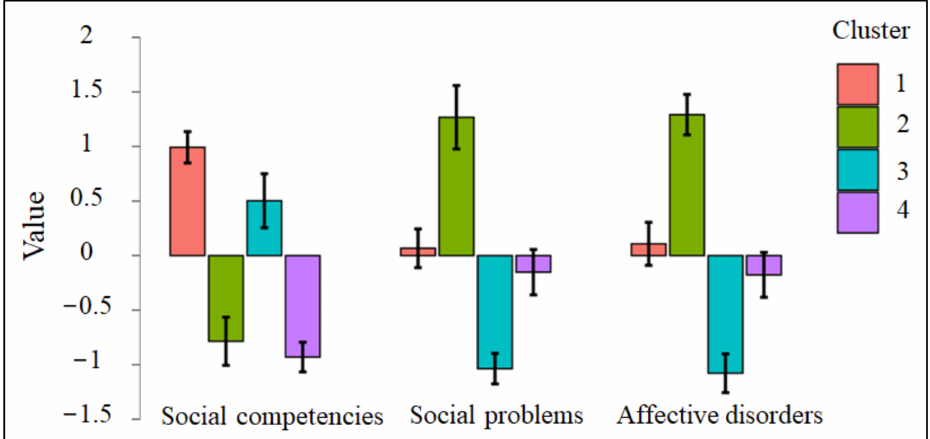
Figure 1. Trends of the four clusters on the selected YSR scales. Notes : Cluster 1 = moderate affective difficulties with discrepant social functioning; Cluster 2 = socio-affective impairment; Cluster 3 = good socio-affective functioning; Cluster 4 = low affective difficulties with discrepant social